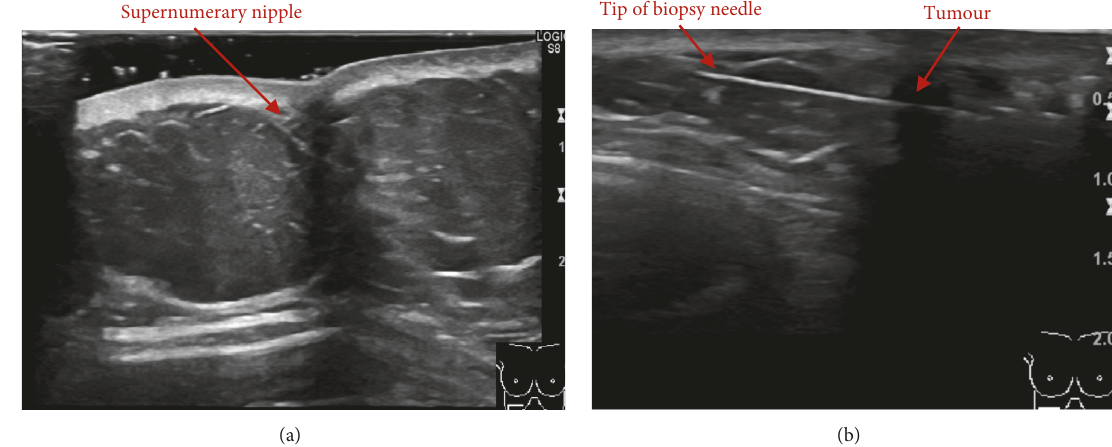
Figure 2: Ultrasound of upper abdominal wall right side (a). Ultrasound guided needle core biopsy (16G) of the tumour located on the upper abdominal wall right side (b).